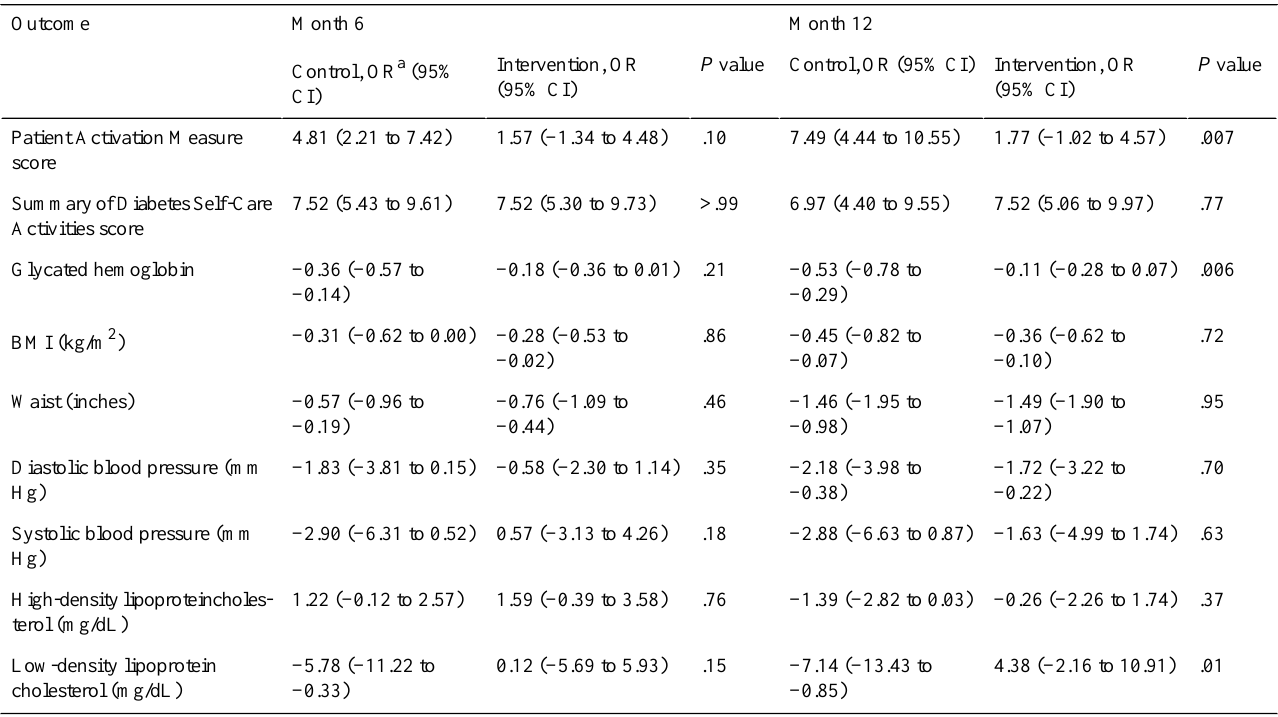
Table 4. Analysis of change from baseline at midpoint and study